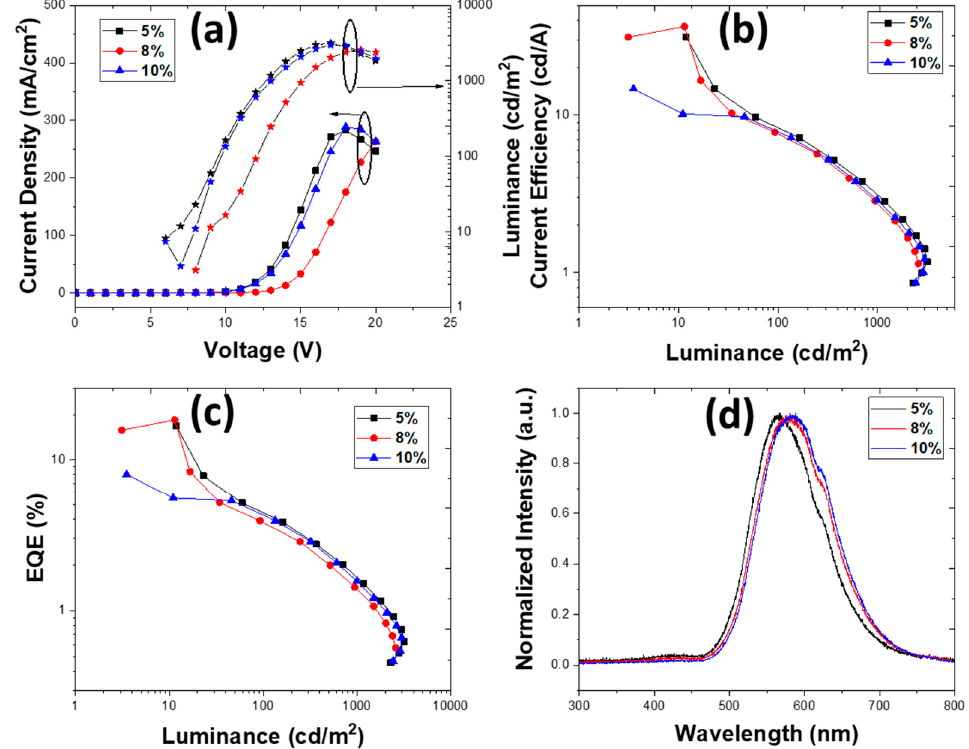
Figure 7. Device characteristics for structure ITO/PEDOT:PSS (40 nm)/PVK:OXD7:TXO-TPA (x wt.%) (40 nm)/TmPyPb (40 nm)/LiF (1 nm)/Al (100 nm) deposited from chlorobenzene. ( a ) current density vs. voltage vs. luminance, ( b ) current efficiency vs. luminance, ( c ) EQE vs. luminance, and ( d ) electroluminescence spectra for 5, 8, and 10 wt.% (at 14 V). Table 4. Summary of results obtained for device with structure ITO/PEDOT:PSS (40